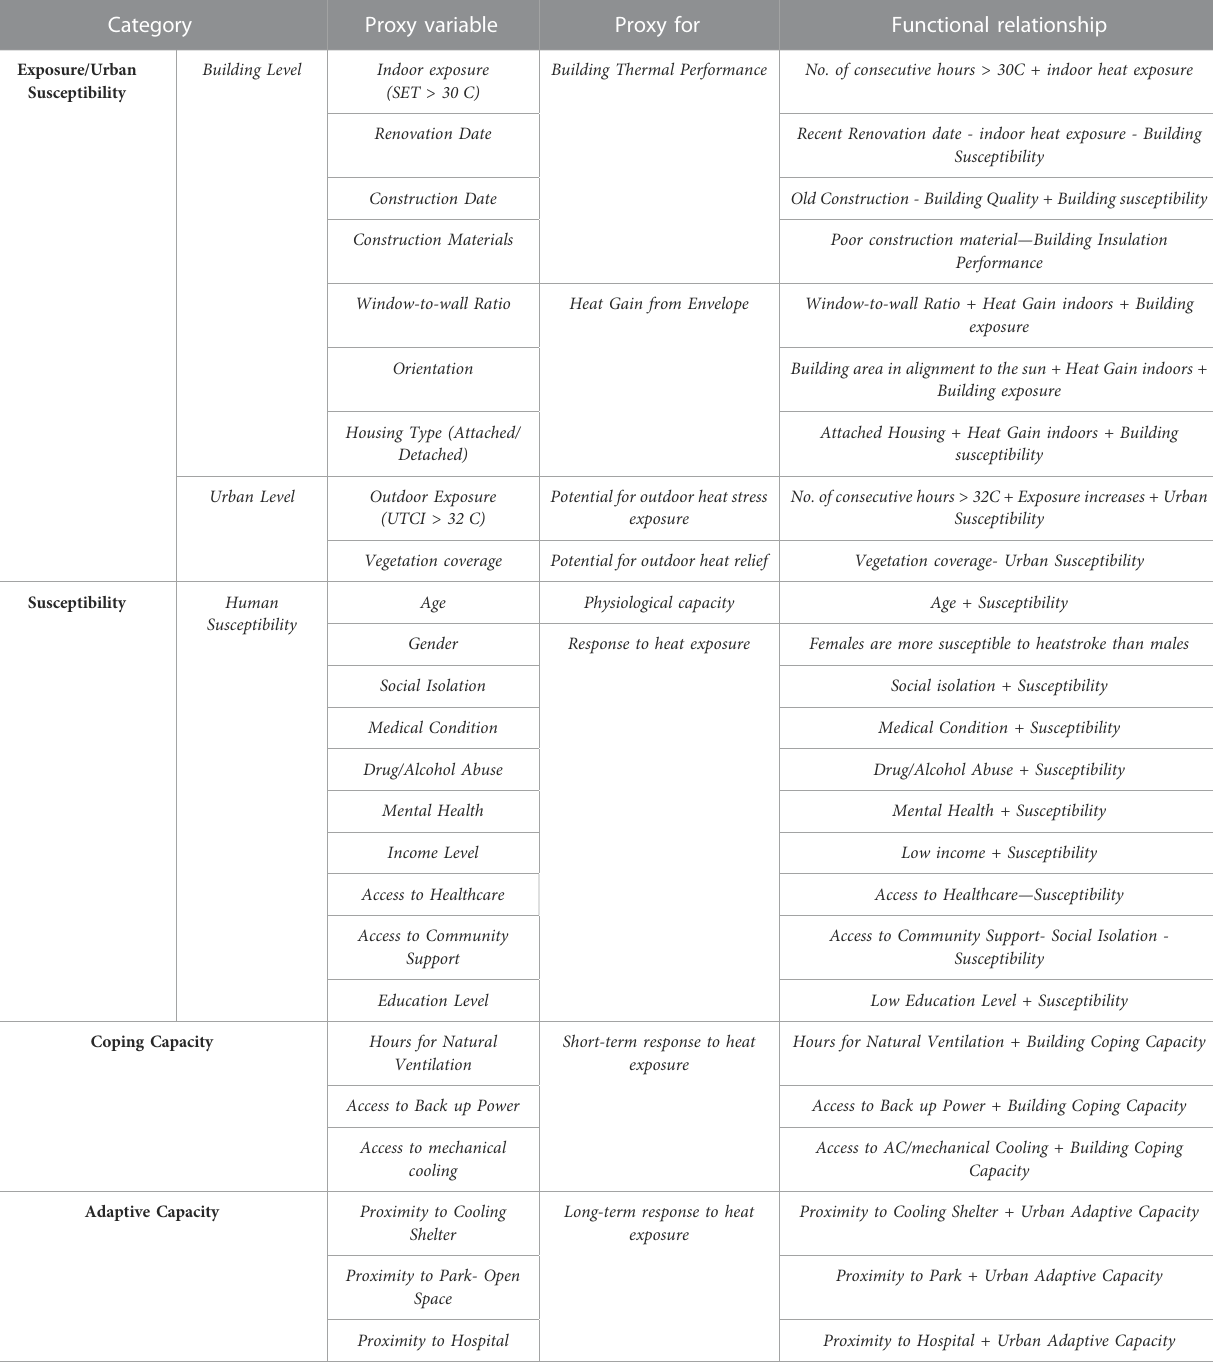
TABLE 2 Description of major and sub-components of heat vulnerability Assessment